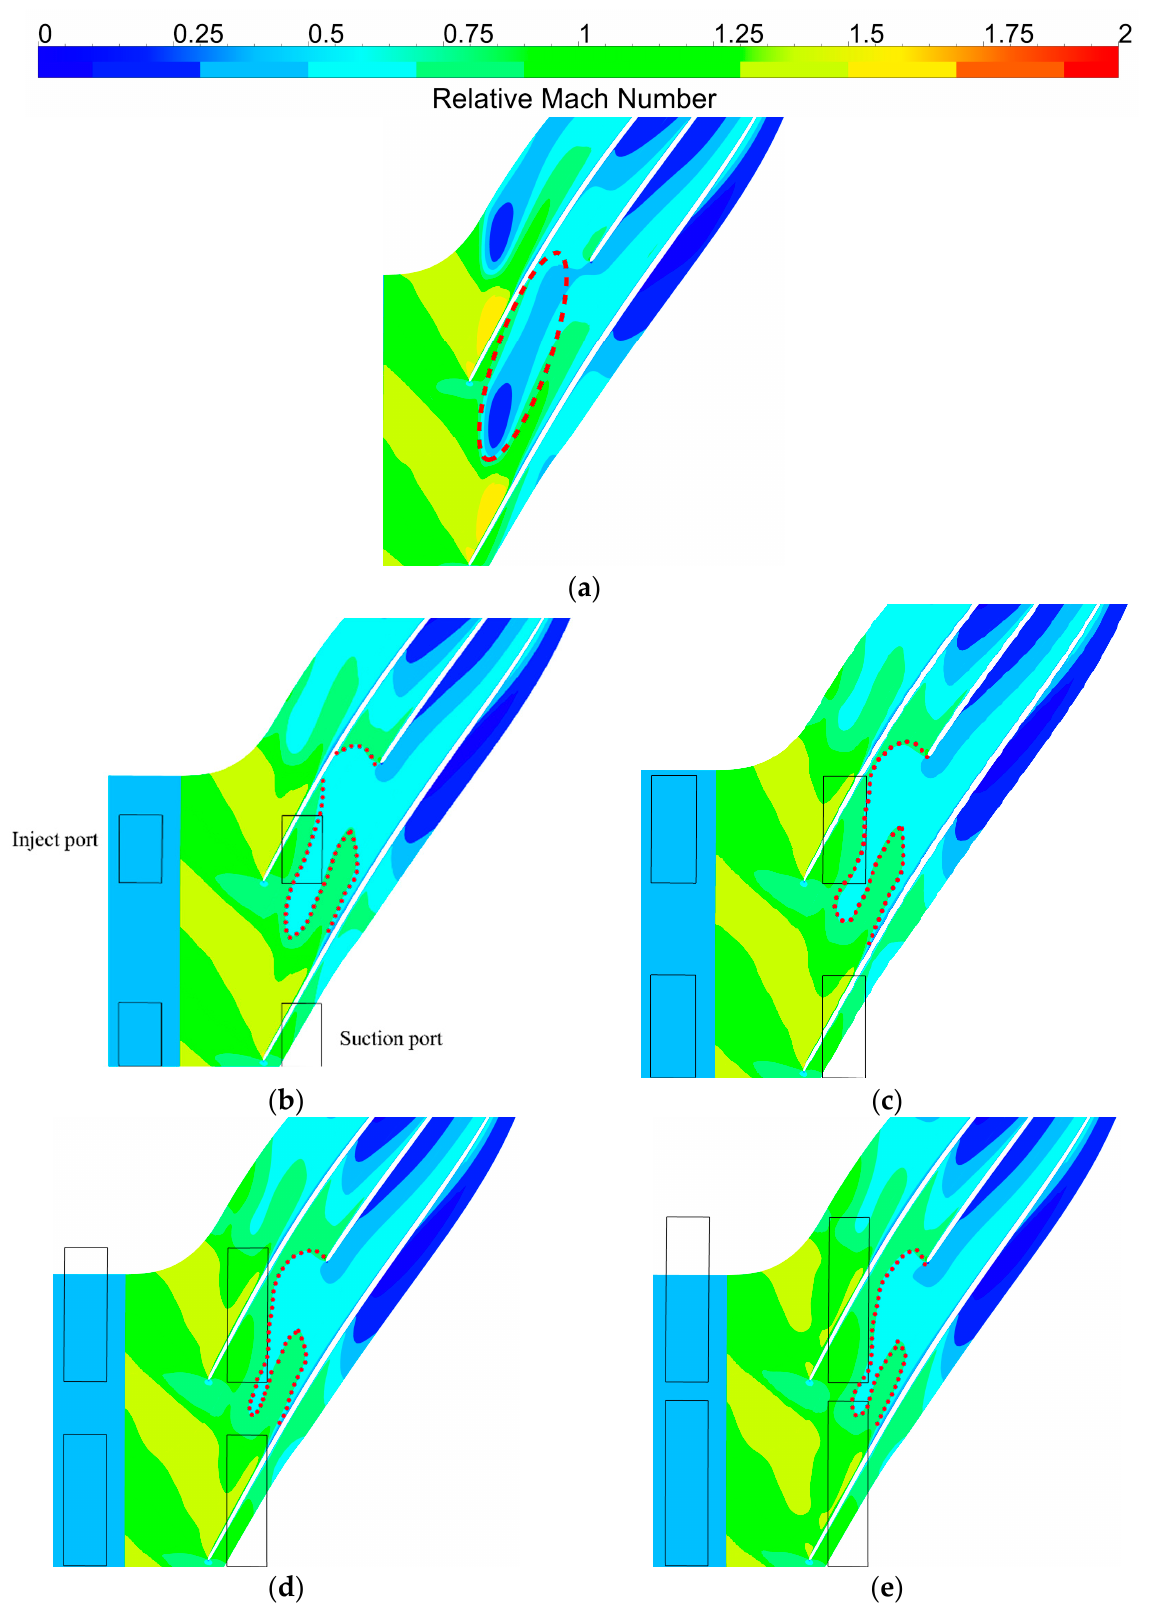
Figure 13. Contours of relative Mach number distribution of different schemes at 96% blade span.